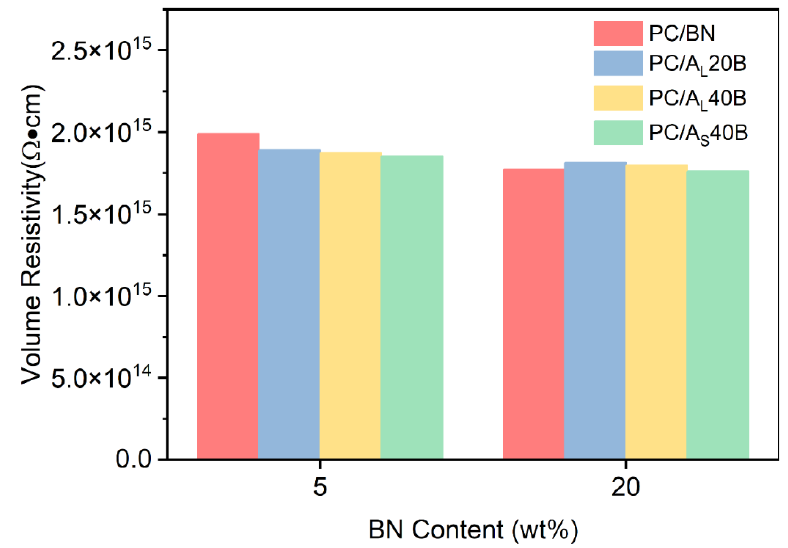
Figure 9. The volume resistance of PC/BN and PC/Al 2 O 3 /BN